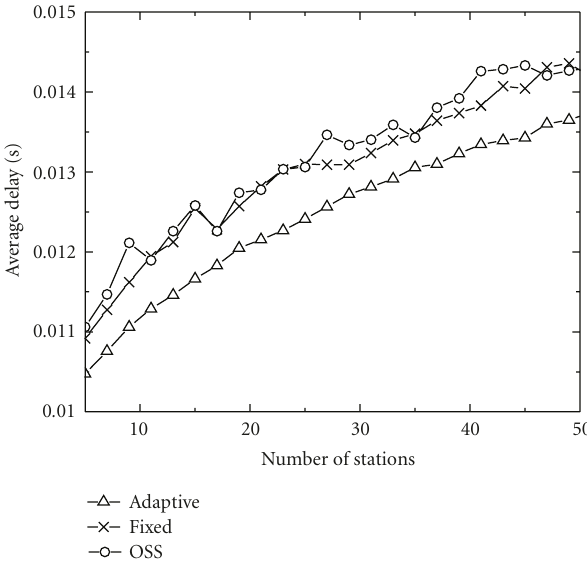
Figure 10: Average packet delay as a function of number of stations.